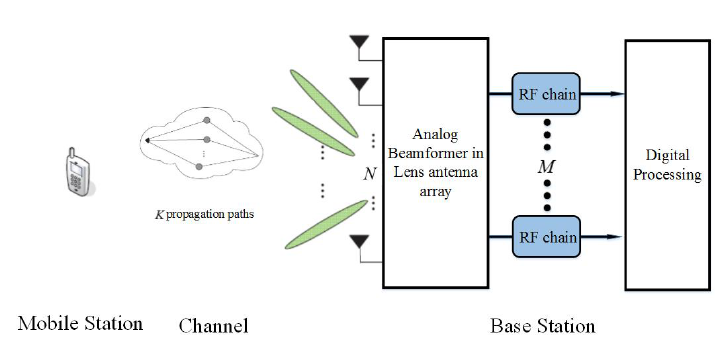
Figure 1. The architecture of the massive MIMO system with lens antenna